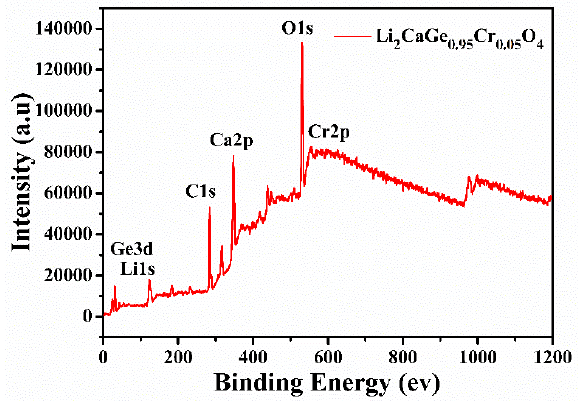
Figure 12. X-ray photoelectron spectroscopy (XPS) survey spectra of the Li 2 CaGe 0.95 Cr 0.05 O 4 crystal. Table 2. The peak banding energy of the elements of the Li 2 Ca 0.95 Cr 0.05 GeO 4 crystals. Element